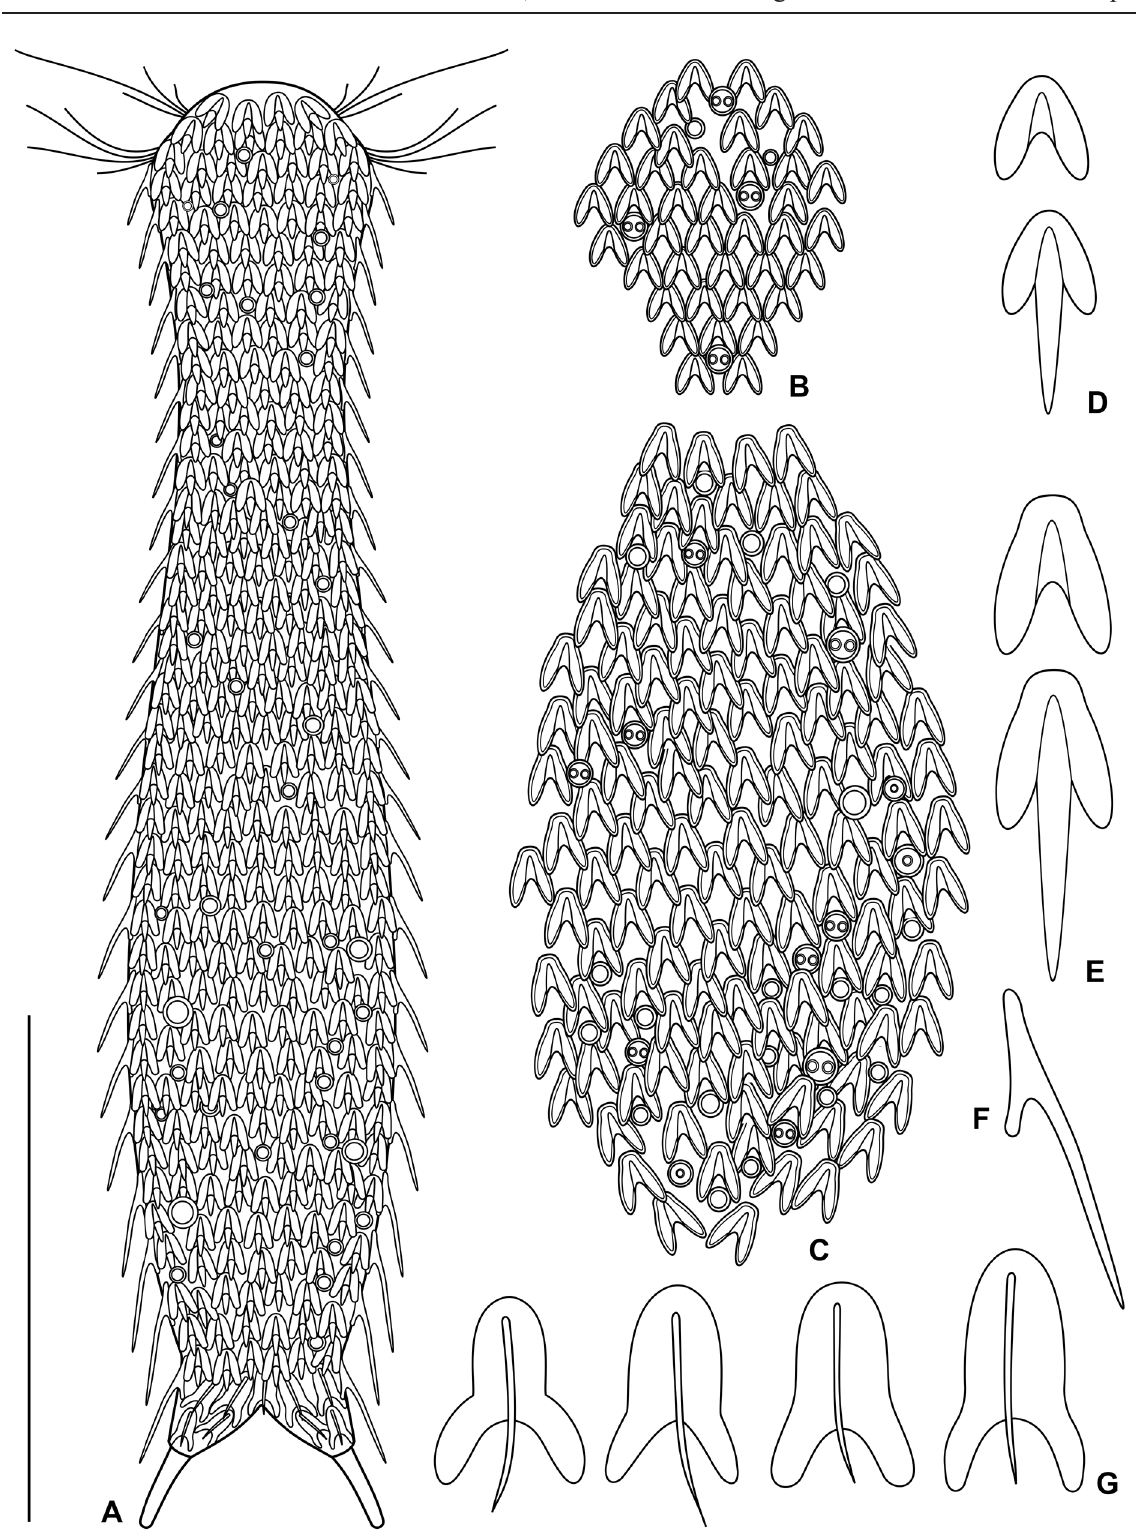
Fig. 18. Chaetonotus ( Hystricochaetonotus ) optabilis sp. nov. A . Dorsal overview showing the scale and spine pattern. B – C . Details showing the distribution of head and trunk scales. D–E . Head and trunk scales, the schematic drawing of the scale base is shown above that of spined scales. F . Lateral view of a trunk spined scale. G . Dorsal furcal scales. Scale bar = 30